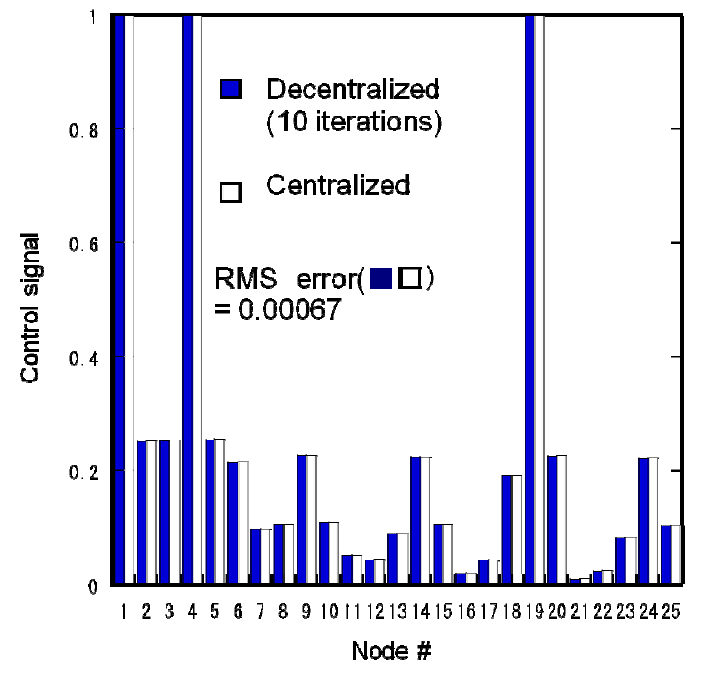
Figure 9. Experimental distributed actuation results obtained using simulations of centralized and proposed decentralized algorithms.